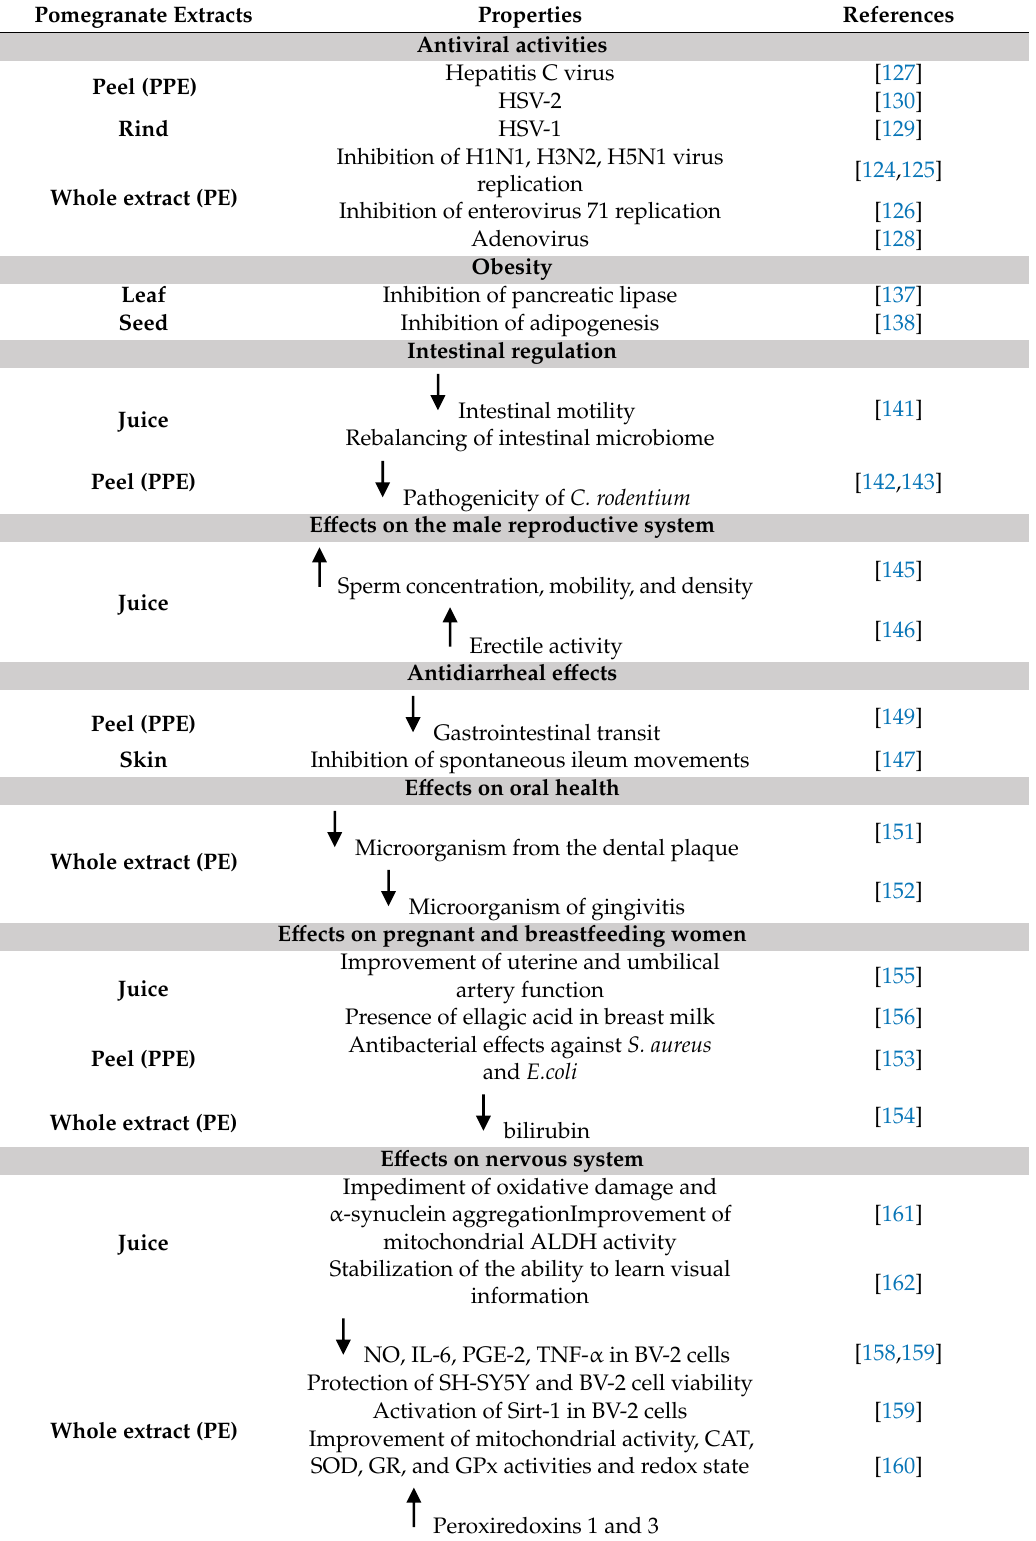
Table 2. Biological properties of different pomegranate extracts.